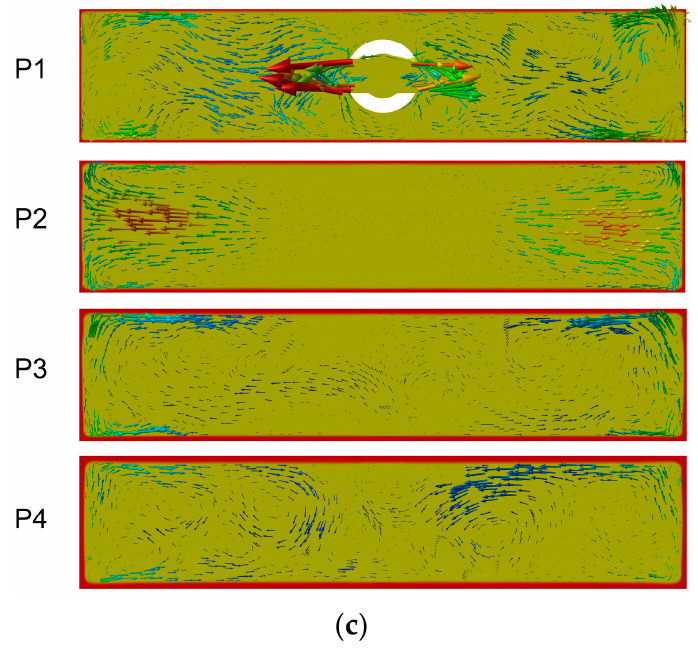
Figure 13. Velocity vector diagram and liquid volume fraction contour diagram at argon gas flow rate of 6 L·min − 1 on different reference planes and under the different EMBr modes of: ( a ) Mode 1; ( b ) Mode 2; ( c ) Mode 3.